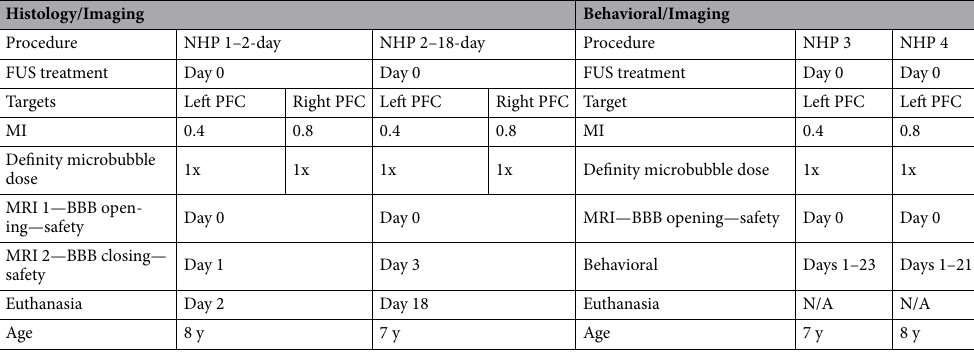
Table 1. Experimental timeline for assessing effects of FUS-induced blood–brain barrier in non-human